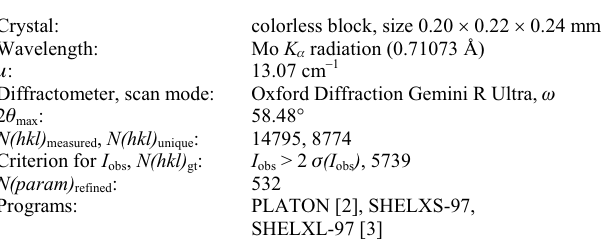
Table 1. Data collection and